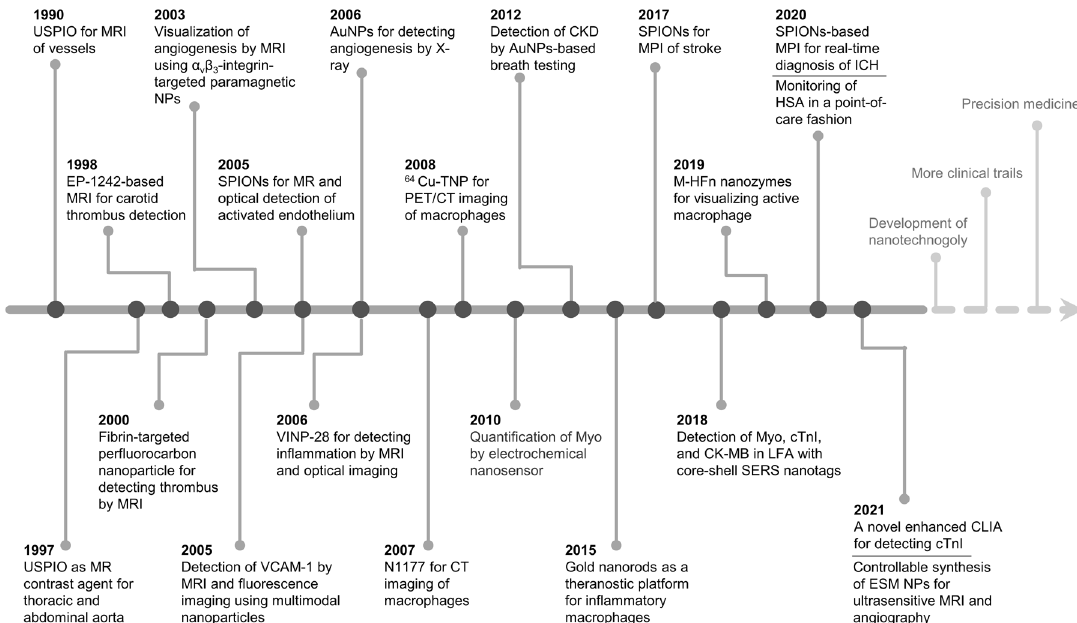
Fig. 5 Historical timeline of nanoparticles used in the diagnosis of vascular aging-related diseases. This timeline scheme was made using the Web of Science database. Key discoveries are highlighted. USPIO ultrasmall superparamagnetic iron oxide particles, MR magnetic